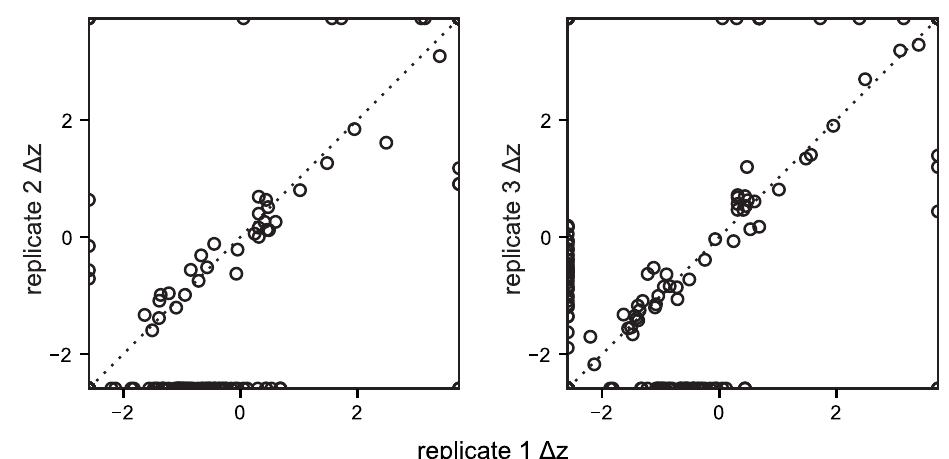
Fig 3. OTUs in replicate units have correlated dynamics. The dynamics of OTUs (circles) in three replicate bioreactors (replicate 1, x-axis; replicates 2 and 3, y-axes) inoculated with the same material and subjected to the same conditions. The dotted line ( y = x ) indicates a perfect correlation: an OTU on this line would have exactly the same Δ z in both replicates, while deviations show differences in dynamics. For example, in the left plot, OTUs above the dotted line experienced a greater increase in abundance in replicate 2 than in replicate 1 (or, a smaller decrease in 2 than in 1), while OTUs below the line “ grew more ” in replicate 2 than in replicate 1 (or, “ died less ” in 2 than in 1). OTUs with infinite Δ z are plotted on the plot ’ s borders (e.g., the points in the lower- right corner of the first plot represent OTUs that have Δ z = + 1 in replicate 1 and Δ z = − 1 in replicate